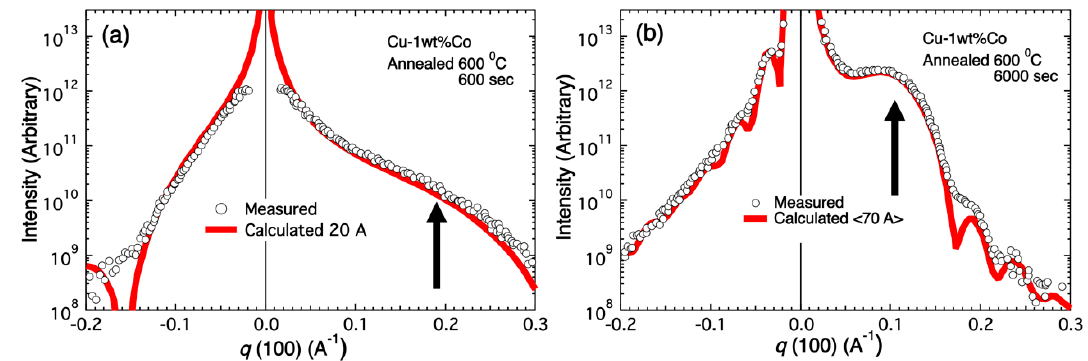
Figure 10. Diffuse scattering measurements (open circles) performed at the wavelength of the Cu K-edge at the [400] reflection of Cu-1wt%Co crystals. The measurements were performed after aging for 600 s (Figure 10a) and 6000 s (Figure 10b) at 600 °C to nucleate and ripen spherical coherent Co precipitates. The thick red lines correspond to diffuse scattering calculations made using 𝜀 = − 0.014 for 20-Å-radius precipitates (Figure 10a) and a volume-weighted average of 65-, 70-, and 75-Å-radius precipitates (Figure 10b).